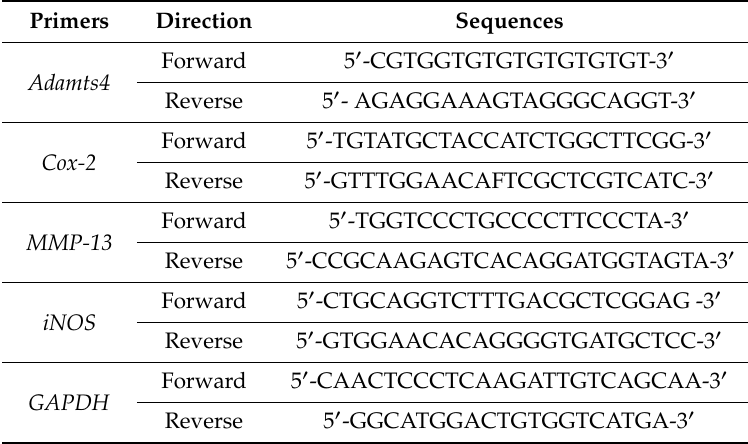
Table 1. Primer sequences for references and target